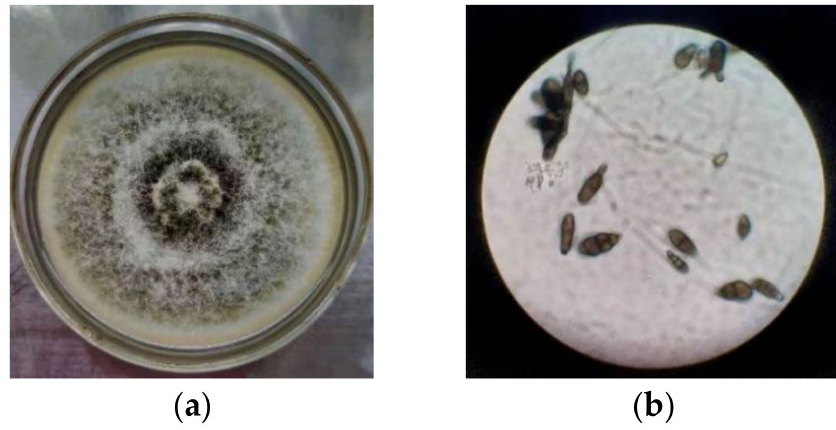
Figure 1. Colony ( a ) and spore ( b ) morphology of strain SPS-2.